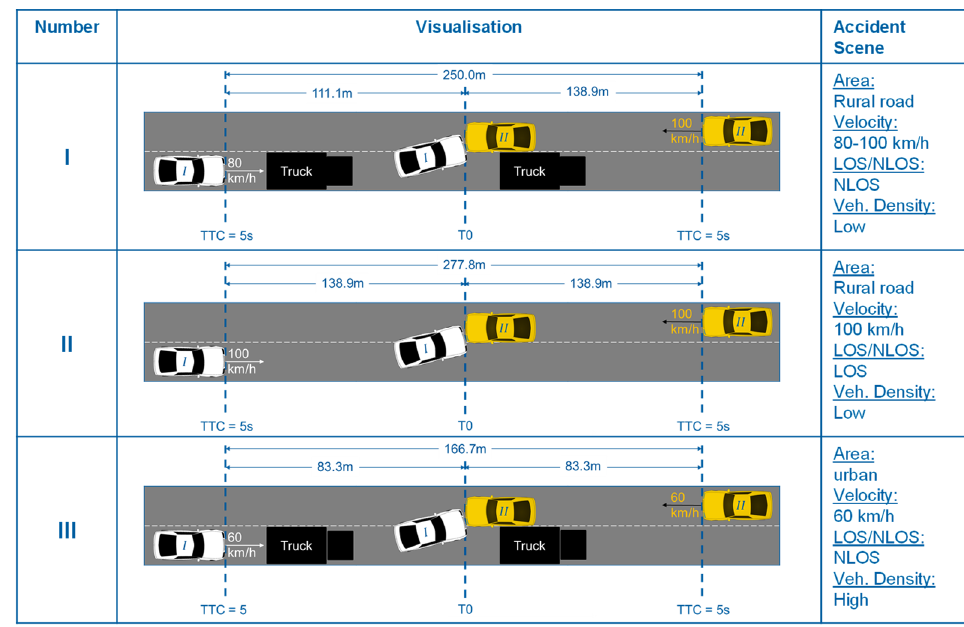
Figure 5. Illustration of the investigated “worst-case” oncoming traffic scenarios (50 + 51).